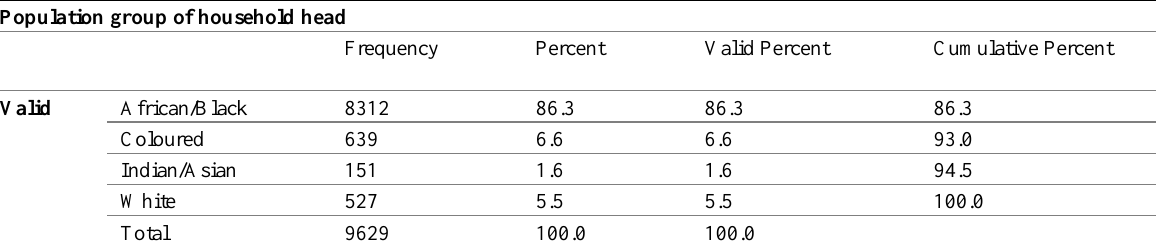
Table 4: Distribution of the population groups